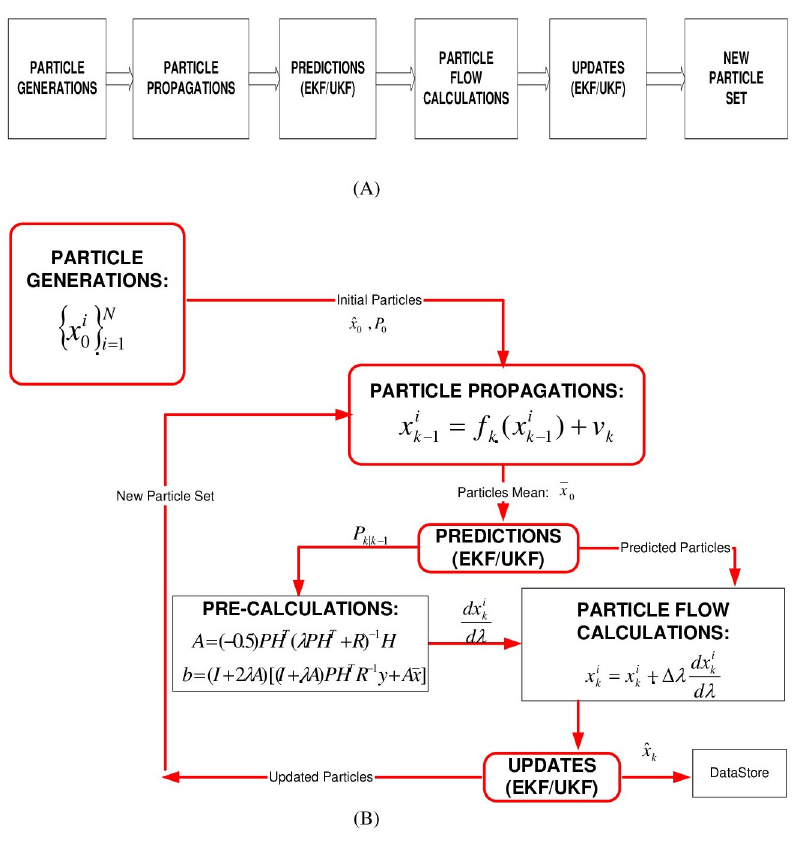
Fig 2. Particle flow filter based A-SLAM algorithm. (A) General block diagram. (B) Flow chart